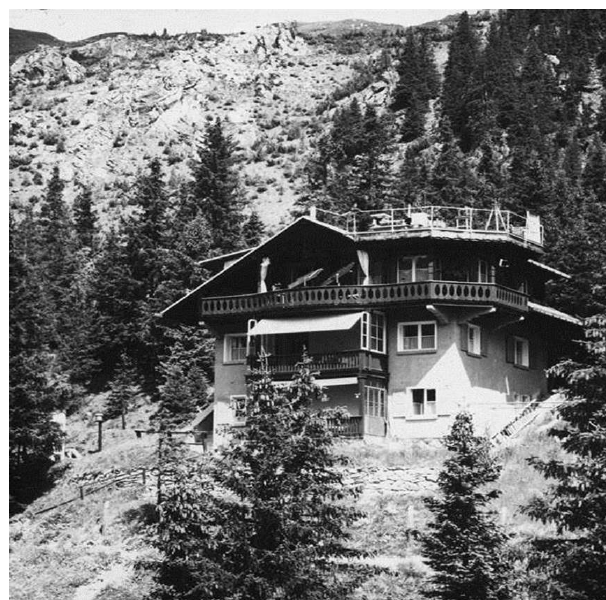
Figure 3. “Villa Firnelicht”, Götz’s house in which the LKO, Götz’s observatory, was hosted (see